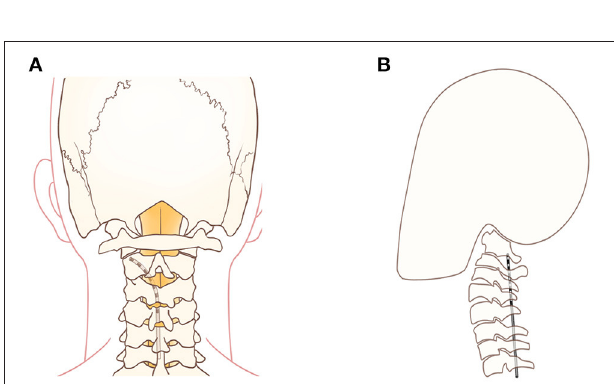
FIGURE 4 | (A) A schematic drawing showing the stimulation lead placement for the top 2 contacts that were positioned lateral to the spinal cord midline for high cervical SCS. (B) A schematic drawing showing the stimulation lead placement for high cervical SCS at the level of the C1–C2